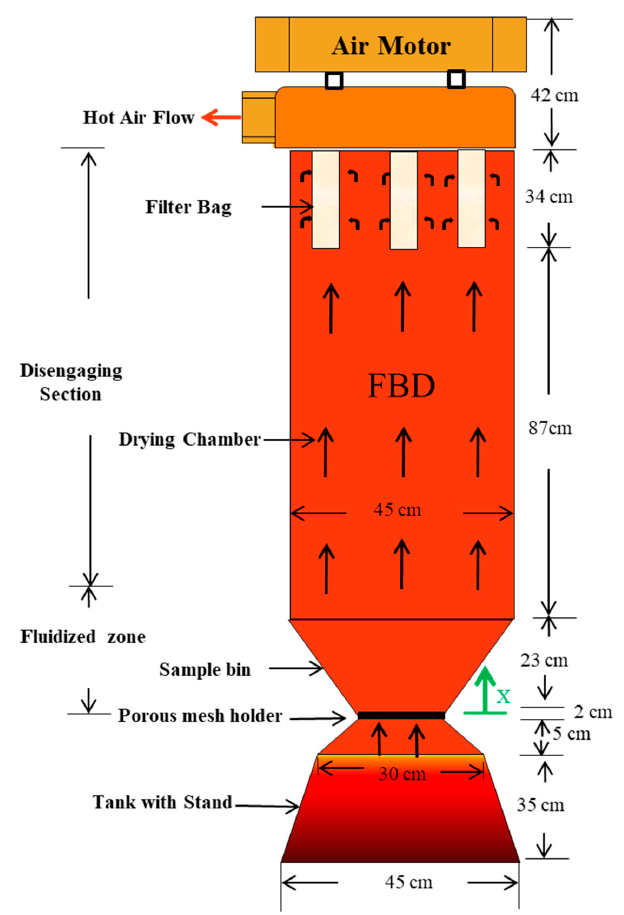
Figure 1. Geometry and dimension of the fluidized bed dryer (FBD) used in this study.